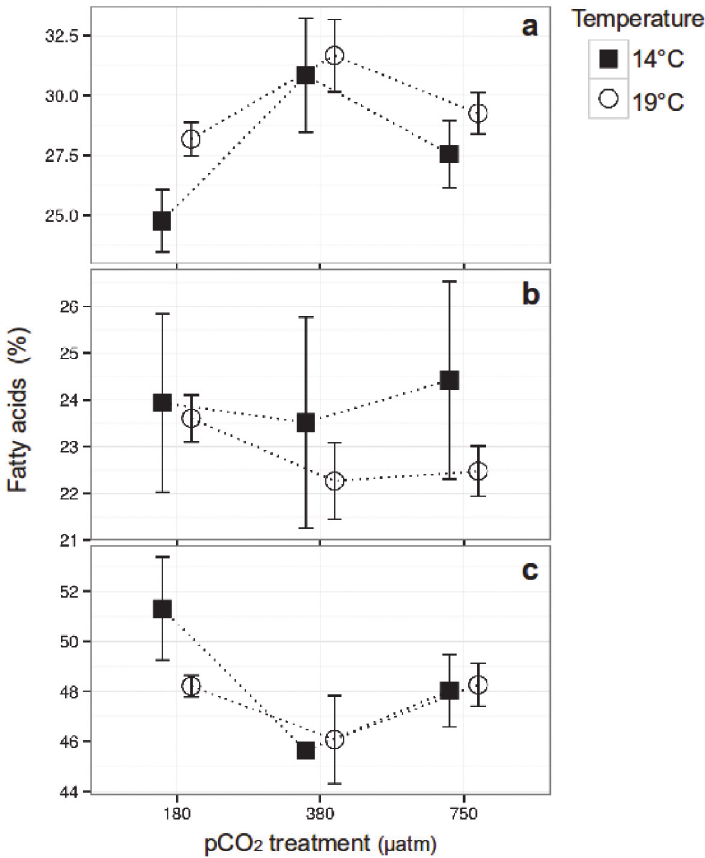
Fig 1. Relative fatty acid content in Cylindrotheca fusiformis . (a) Polyunsaturated [PUFA], (b) Monounsaturated [MUFA] and (c) Saturated [SFA] fatty acids, cultured under three CO 2 levels and two temperatures conditions for > 250 generations. a) PUFA showed a significant CO 2 and temperature effect with a maximum at the intermediate CO 2 treatment and an overall higher concentrations at 19°C. b) MUFA showed no differences between the treatments. c) SFA showed a significant difference related to CO 2 but no temperature effect. Error bars denote ± 1 standard deviation (n =